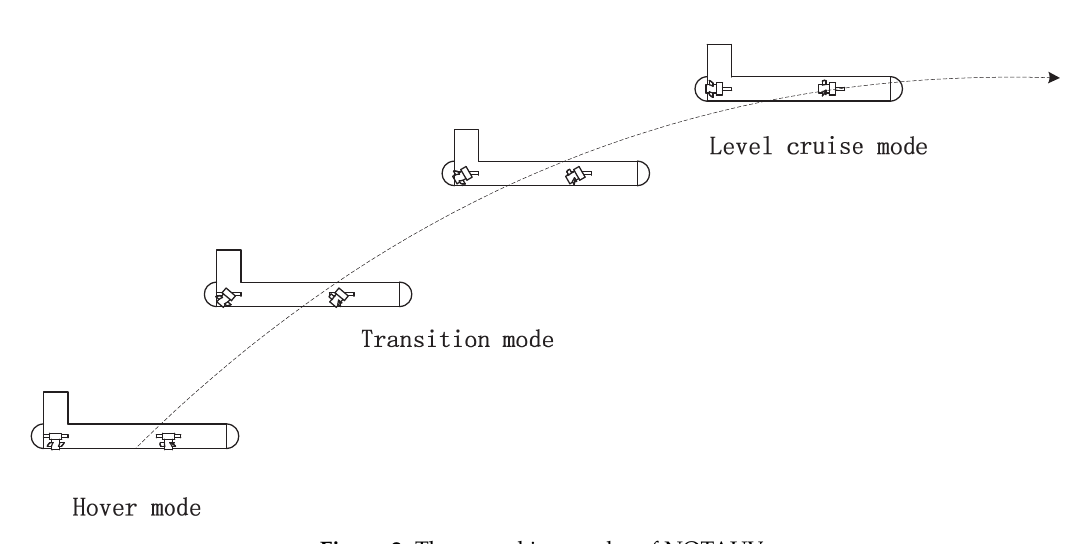
Figure 2. Three working modes of